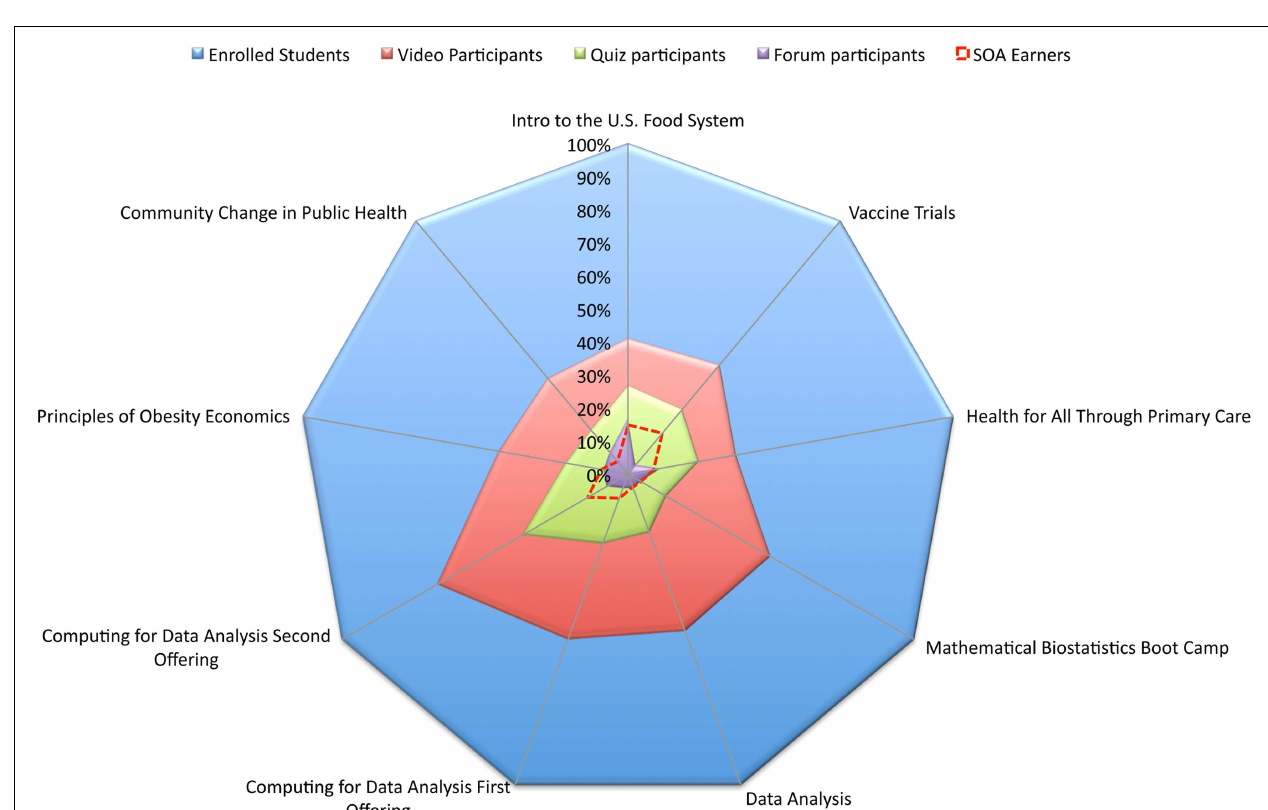
FIGURE 3 | Looking down the funnel of participation in nine JHSPH MOOC offerings .